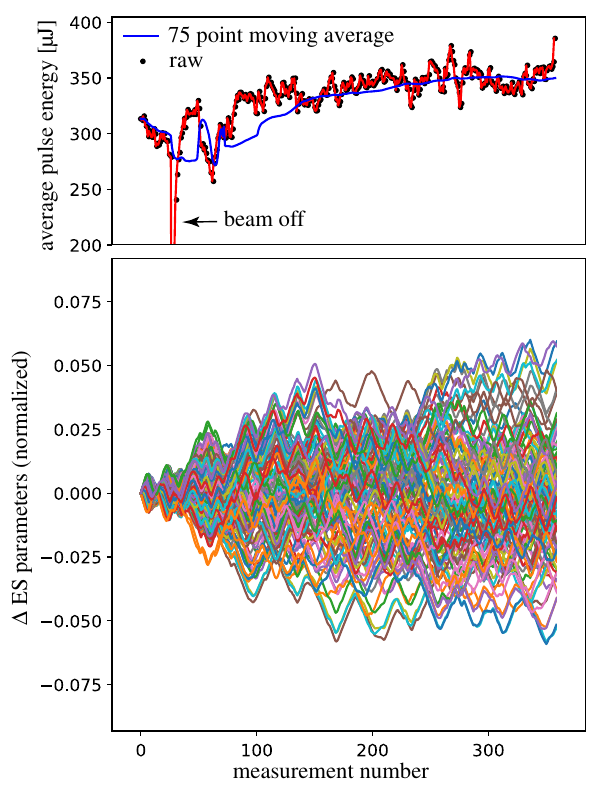
FIG. 9. Tuning 84 air coils and 21 gaps to maximize average bunch energy. No averaging was performed on the cost function, the 75 point moving average is plotted to help visualize energy